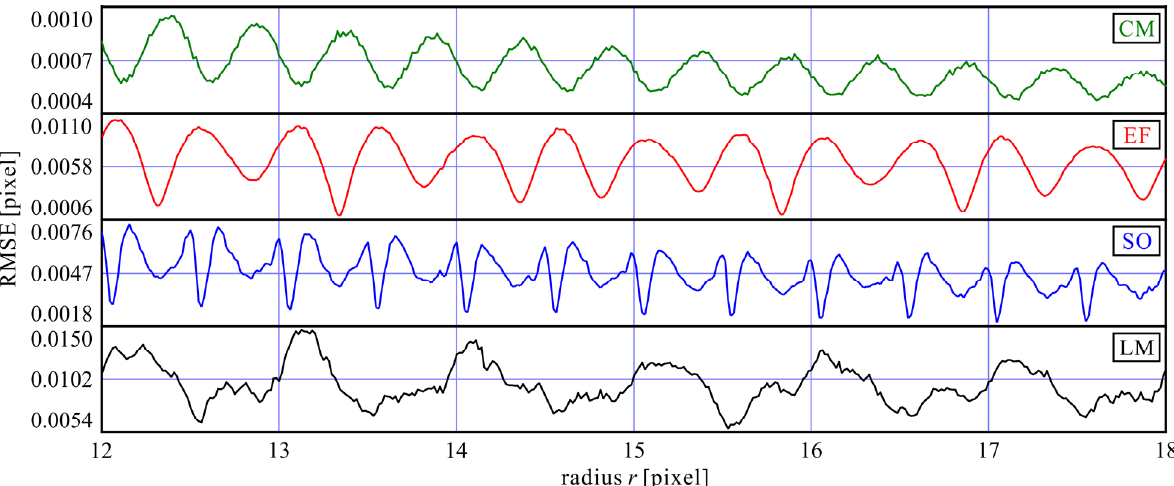
Figure 4. RMSE of the center location measurement of a circle (12 pixels  r  18